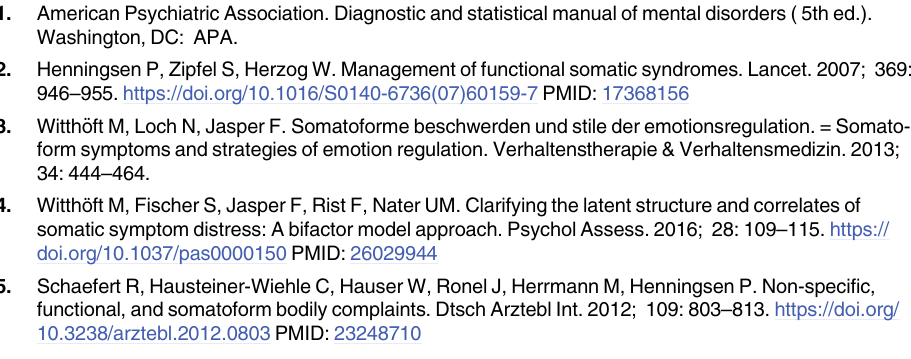
S4 Table. Emotion regulation variables examined in each diagnostic group. S5 Table. Study characteristics and summaries of articles that examined attention-oriented emotion regulation. S6 Table. Study characteristics and summaries of articles that examined body-oriented emotion regulation. S7 Table. Study characteristics and summaries of articles that examined knowledge-ori- ented emotion